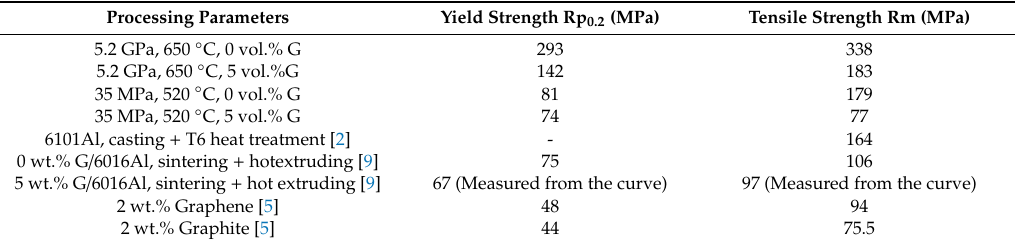
Table 1. Tensile strengths of the composites in this investigation and other reported literature. Processing